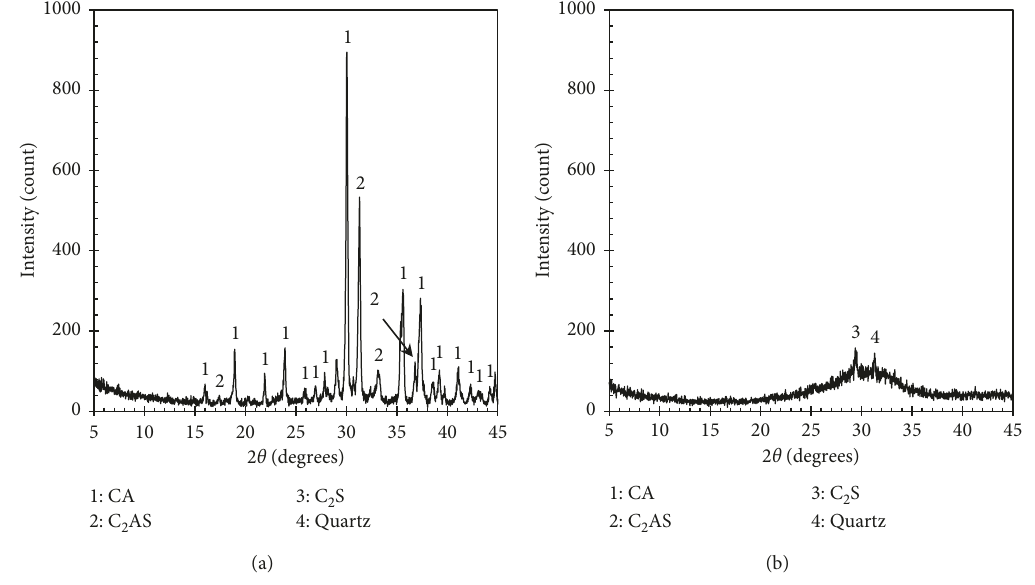
Figure 1: XRD curves of raw materials used in this study: (a) CAC; (b)